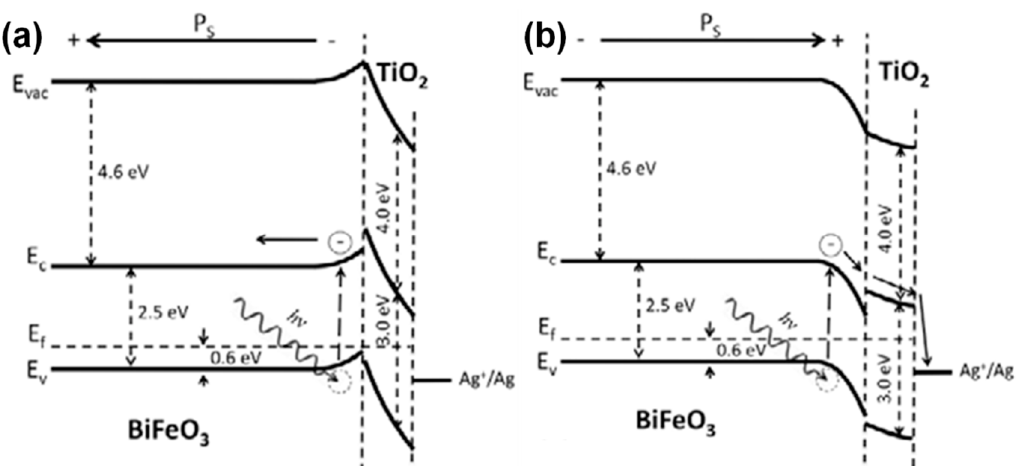
Figure 12. The energy bands at the BiFeO 3 / TiO 2 interface bend ( a ) upward and ( b ) downward corresponding to the applied polarization (reproduced with permission from ref. [162]).